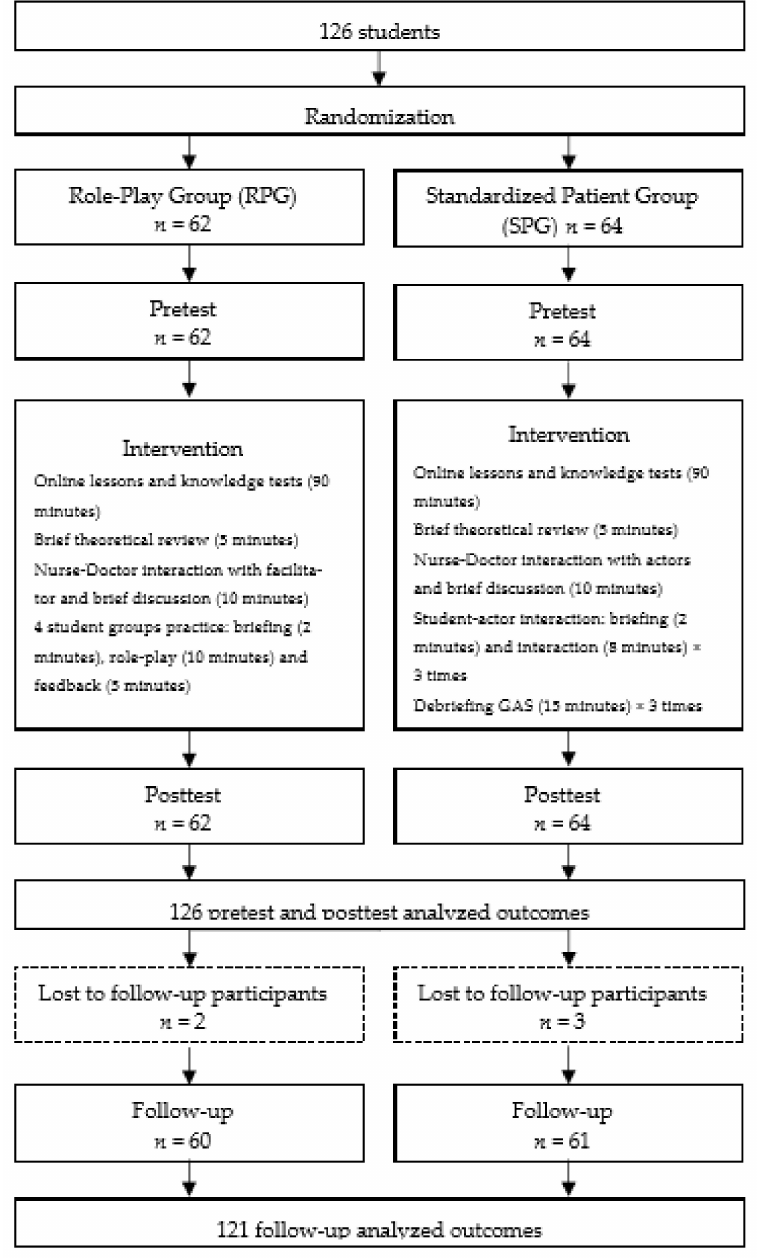
Figure 1. Protocol for randomisation and